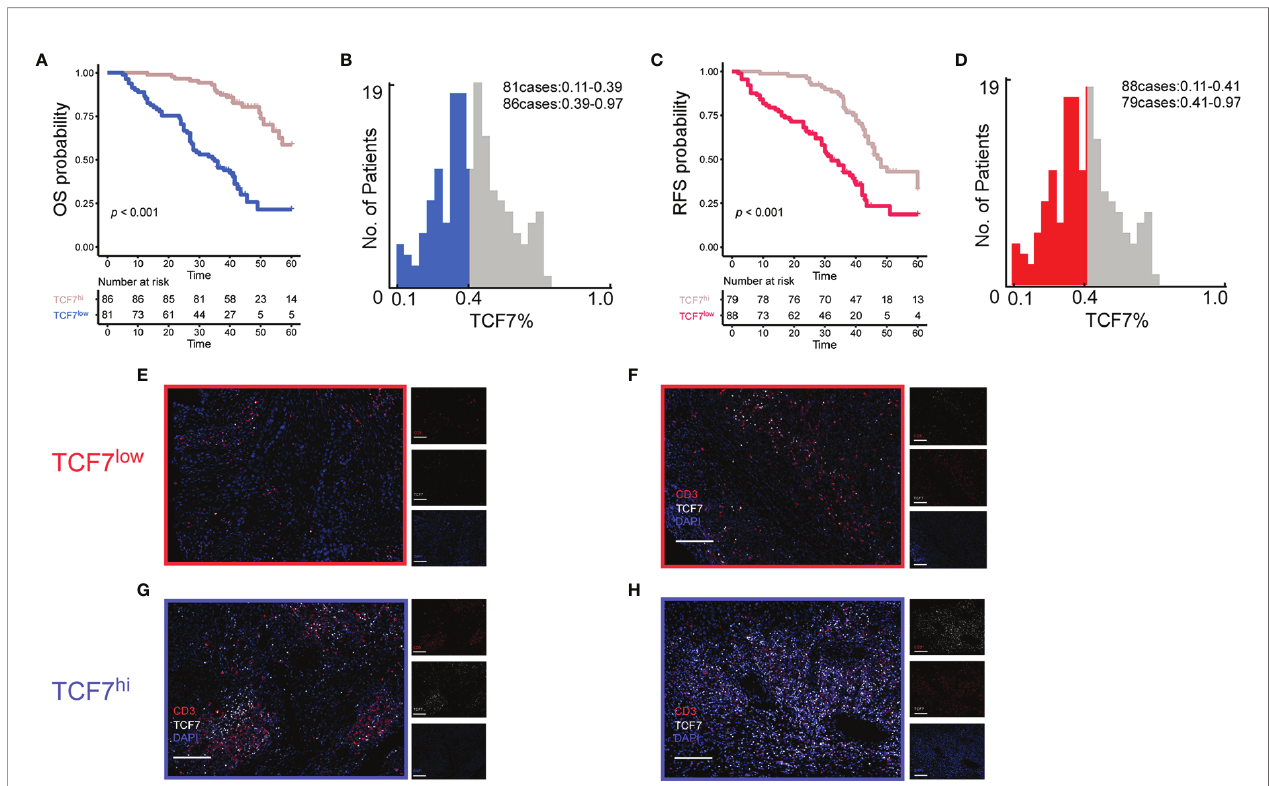
FIGURE 1 | A total of 167 patients were classi fi ed into the TCF7 + T cell low expression group and TCF7 + T cell high expression group based on optimal cutoff values of 0.39 (B) and 0.41 (D) for OS (A) and RFS (C) , respectively, using X-tile software. Representative multiplex immuno fl uorescence results plots were selected in each of the two groups to demonstrate the expression of TCF7 + T cells in the low expression group (E, F) and high expression group (G, H) . The markers of fl uorescence used were CD3 (red), TCF7 (white), and DAPI (blue). Magni fi cation, 20×; white scale bar, 100 m m; OS, overall survival; RFS, recurrence-free